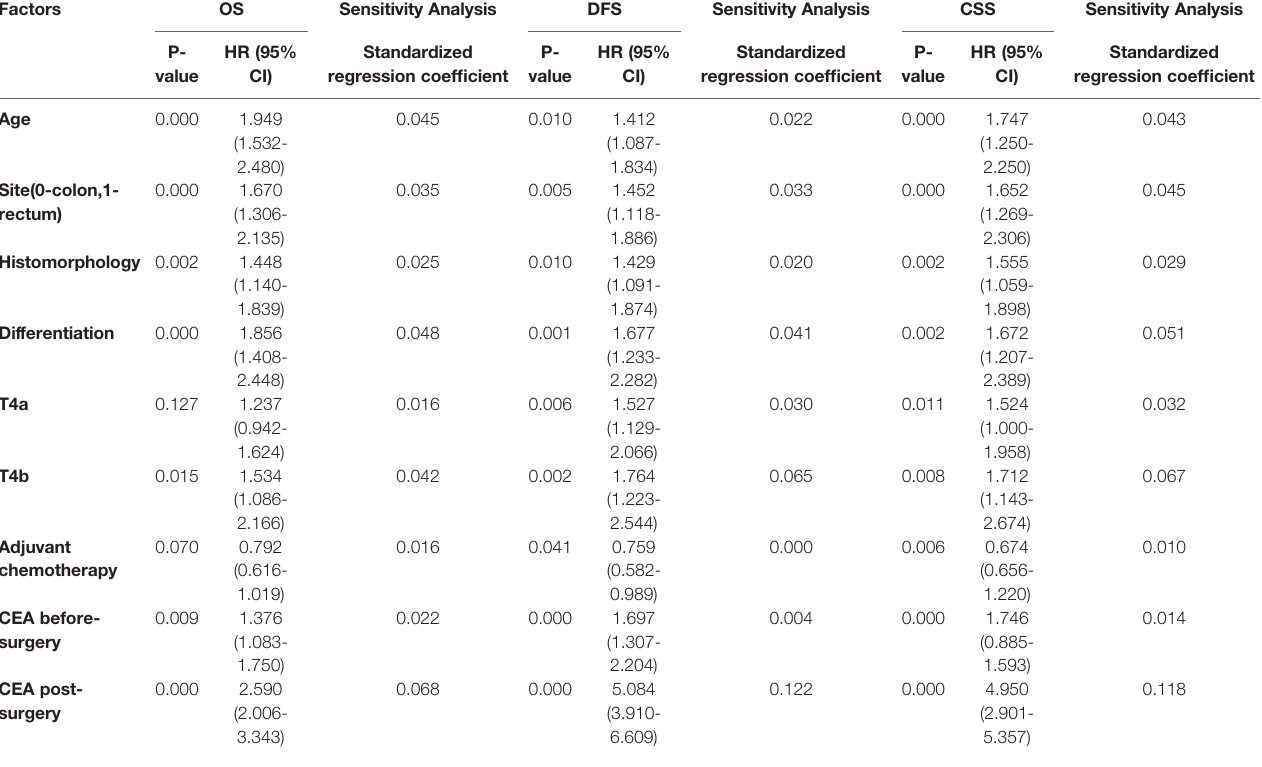
TABLE 3 | Multivariate Cox regression analysis before PS and sensitivity analyses for overall survival (OS), disease-free survival (DFS) and cancer speci fi c survival (CSS).